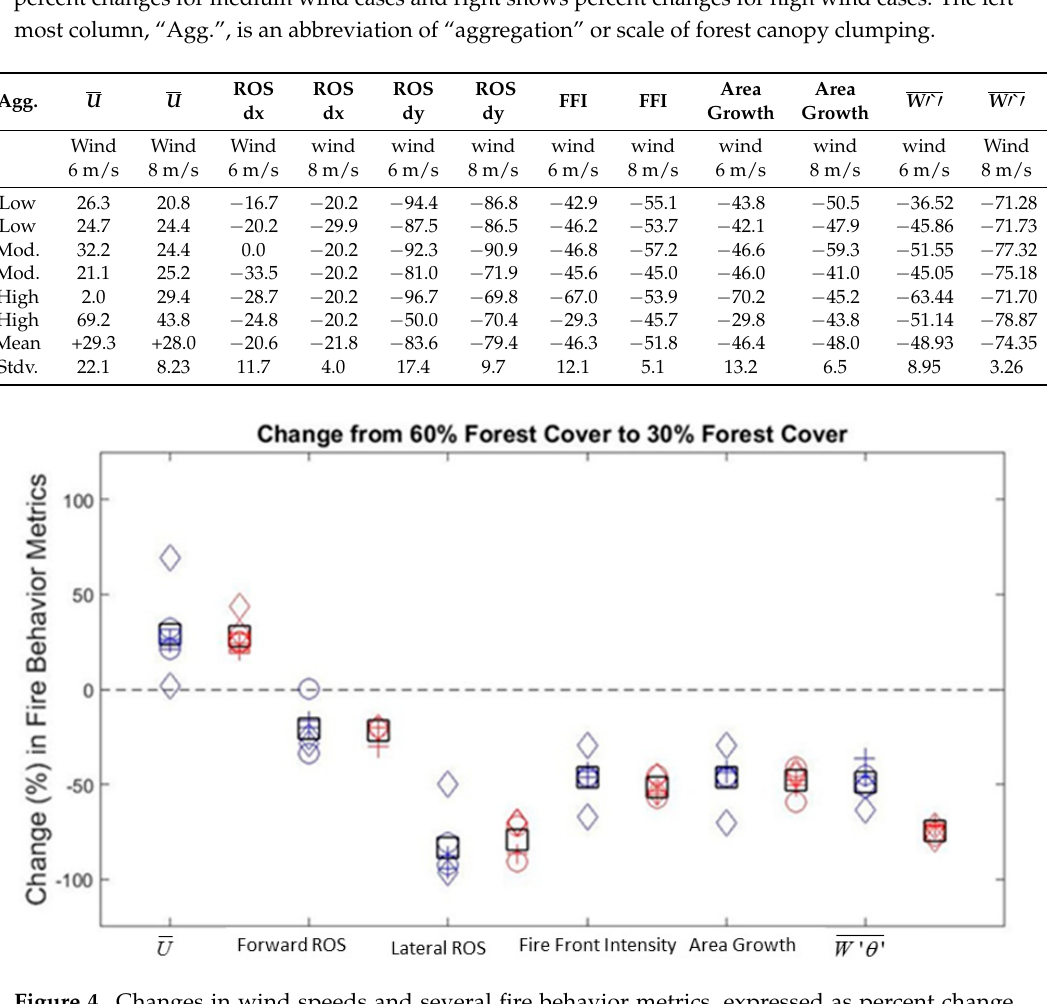
Figure 4. Changes in wind speeds and several fire behavior metrics, expressed as percent change between 60 and 30% canopy cover cases. Blue colors depict moderate wind cases while red depict high wind cases. Three spatial patterns are represented: low aggregation with a plus sign symbol, moderate aggregation with circles, and high aggregation as diamonds. For any plot column, mean percent change is shown with open bold outlined black squares.